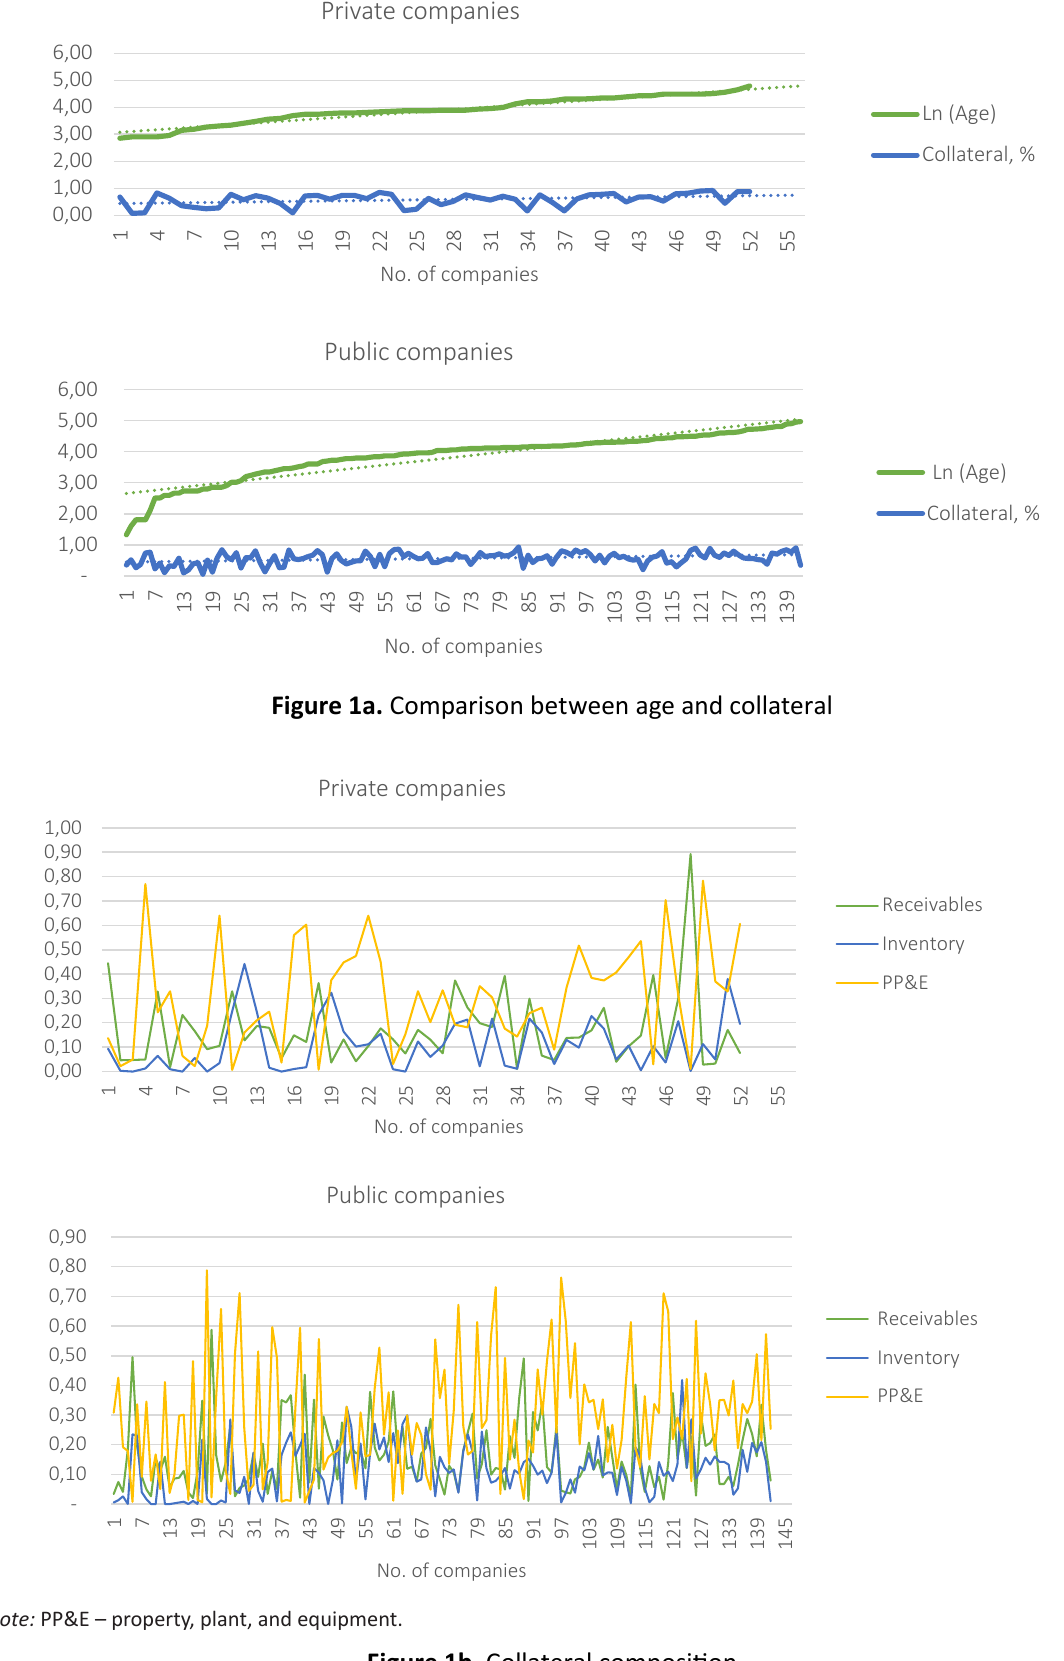
Figure 1b. Collateral composition